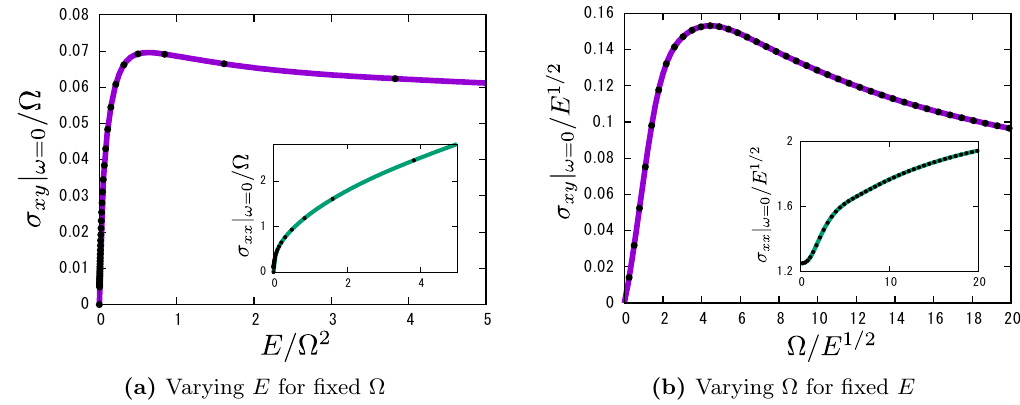
Figure 7. The DC Hall conductivity of the holographic Floquet state. In the left and right (cid:12)gures, parameter are nondimensionalized by (cid:10) and E , respectively. They have maximum values at ( E= (cid:10) 2 ; (cid:27) xy j ! =0 = (cid:10)) = (0 : 639 ; 0 : 0696) [left] and ((cid:10) =E 1 = 2 ; (cid:27) xy j ! =0 =E 1 = 2 ) = (4 : 39 ; 0 : 153) [right]. The insets of these (cid:12)gures are for (cid:27) xx .